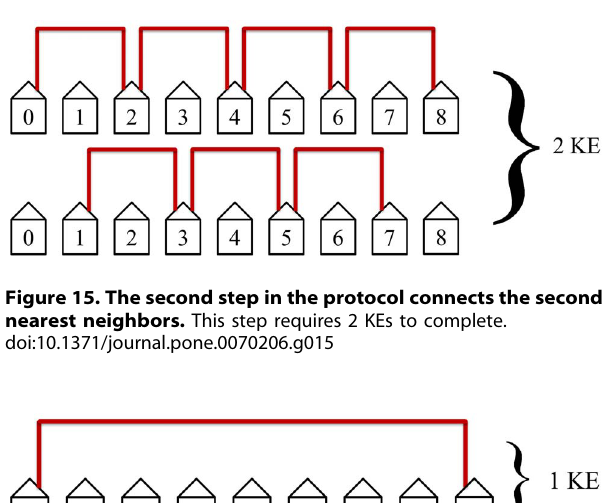
Figure 18. The fifth step in the protocol connects the fifth nearest neighbors. This step is not efficient since simultaneous non- overlapping loops with disconnected hosts cannot occur. It requires 4 KEs to complete.